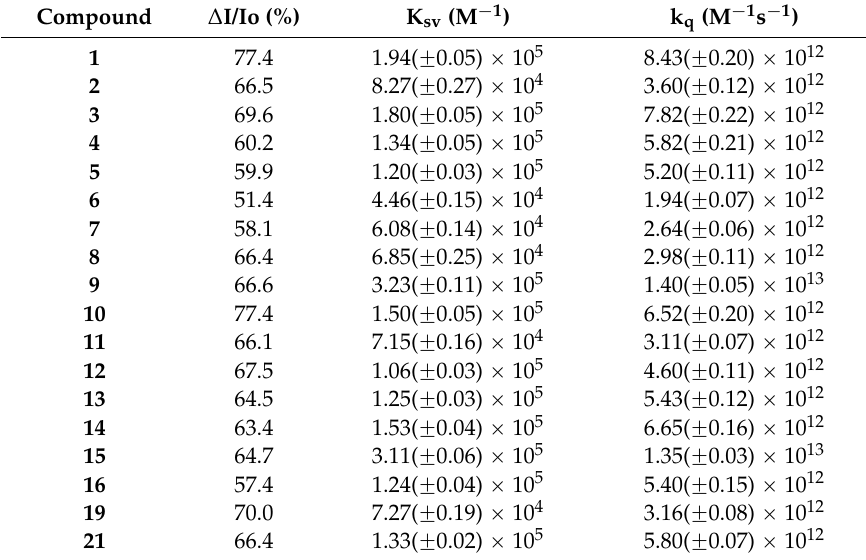
Table 3. Data of the EB-competitive studies of selected compounds. Percentage of EB-DNA fluorescence quenching ( ∆ I/Io, %), Stern-Volmer constants (K SV , M ´ 1 ) and quenching constants (k q , M ´ 1 s ´ 1